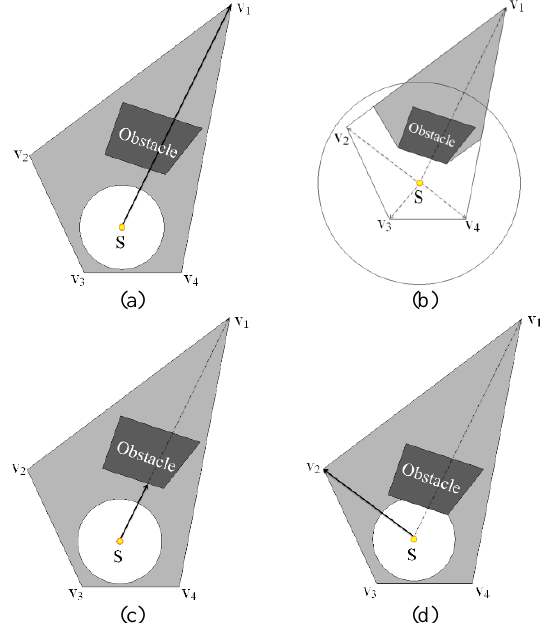
Figure 5. Simple and extended VOR algorithms: (a)